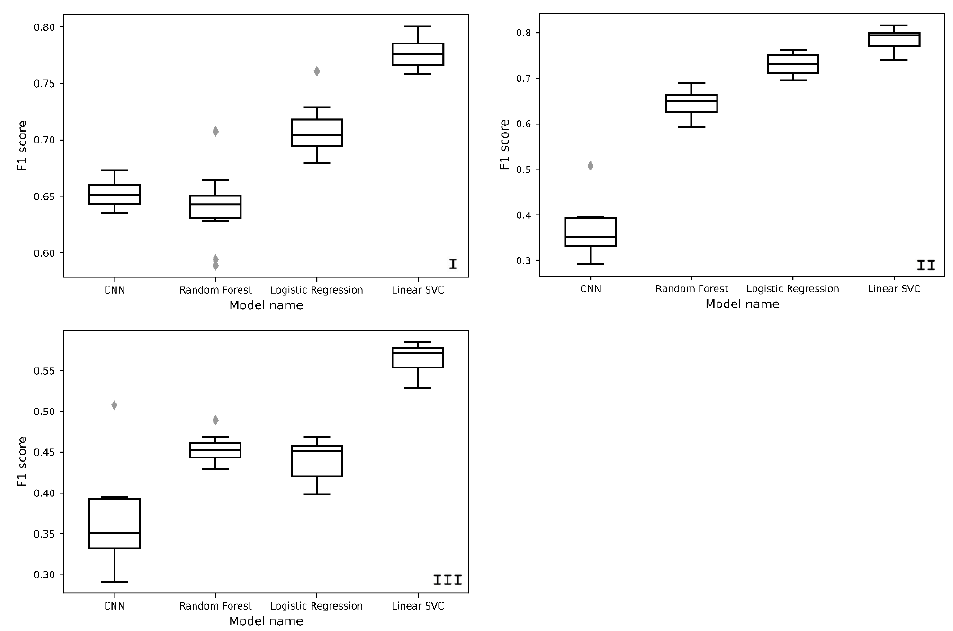
Figure 6. F1-score statistics computed through 10-fold cross-validation of the four classifier models trained on ( I ) 𝐵 𝑡𝑟 (review-level), ( II ) 𝐵 𝑡𝑟 (segment-level), and ( III ) 𝐶 𝑡𝑟 (review-level ).